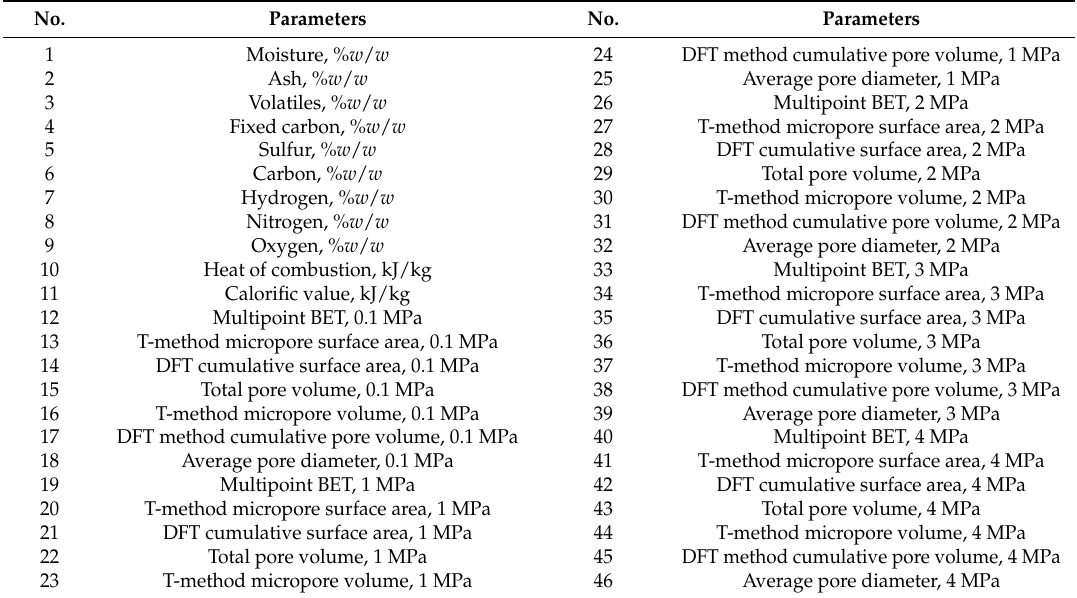
Table 2. Chemical and physical parameters of fuel